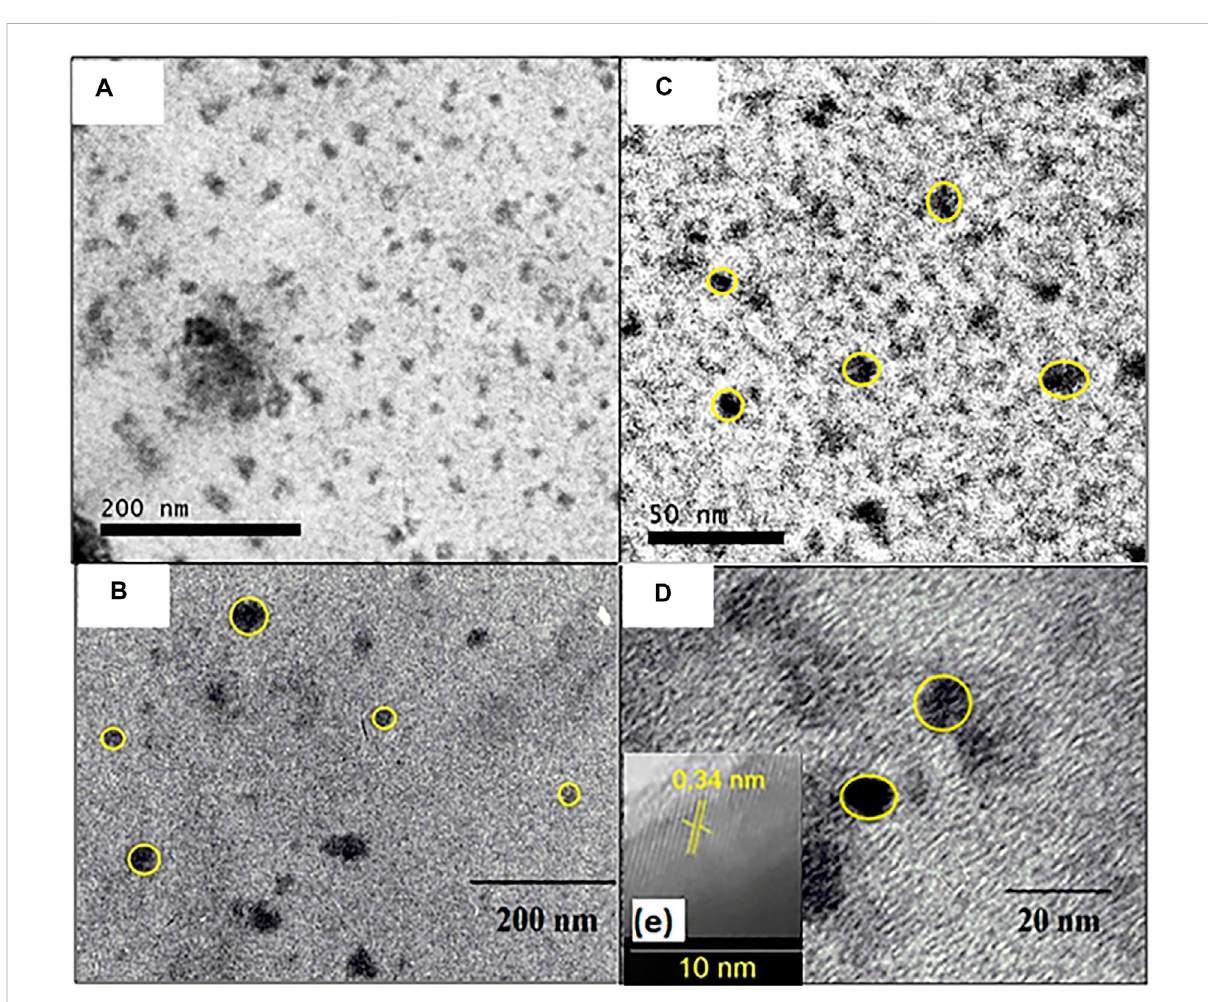
FIGURE 8 TEM images of isolated particles from CQDs prepared by heat exposure at 210 ° C for 30 min in enlarged microwave (A) 200 nm and (C) 20 nm; and TEM images of isolated particles from CQDs prepared by heat exposure at 210 ° C for 10 h in autoclave (B) 200 nm (D) 20 nm and (E) interplanar spacing of clustered CQDs b